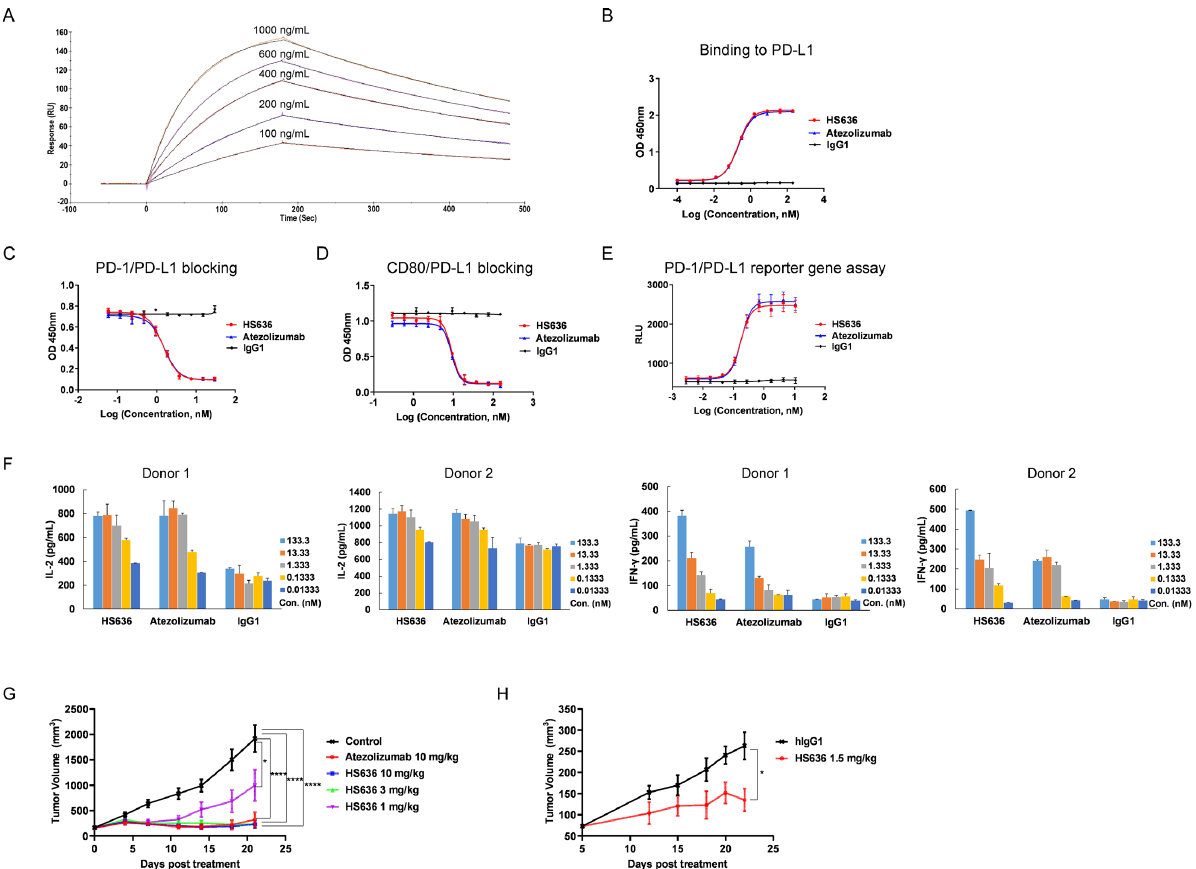
Figure 1. In vitro functional activity and in vivo antitumor efficacy of HS636. ( A )The affinity of HS636 to PD-L1 was detected by Surface plasmon resonance (SPR). ( B ) The binding activity of HS636 to human PD-L1 was determined by ELISA. The blocking activity of HS636 towards PD-1/PD-L1 interaction ( C ) and CD80/ PD-L1 interaction ( D ) was determined by competition ELISA. ( E ) The bioactivity of HS636 on PD-1/PD-L1 signaling was performed by the PD-1/PD-L1 NFAT reporter gene assay. ( F ) The T cell activation effect of HS636 was determined in MLR assay. CD4 + T cells from 2 donors and allogeneic DCs were co-cultured in the presence of indicated concentrations of HS636 for 3 days, then IL-2 and IFN- γ secretion were quantified by ELISA. ( G ) PD-1 humanized C57BL/6 mice bearing MC38/hPD-L1 tumors were treated with HS636, Atezolizumab, or vehicle control ( n = 10 for each group). The tumor volume was measured twice per week. ( H ) NCG mice bearing HCC827 tumors were injected with human PBMCs (1 × 10 7 /mouse) and HS636 or isotype control hIgG1 ( n = 6 for each group). The tumor volume was measured twice per